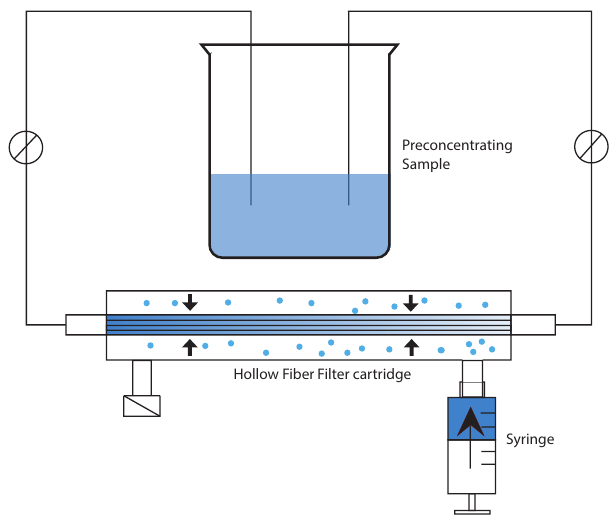
Figure 2. Backflush of hollow fiber filter membrane setup, per- formed by stopping the peristaltic pump and injecting 1mL of ul- trapure water into the open side port using a